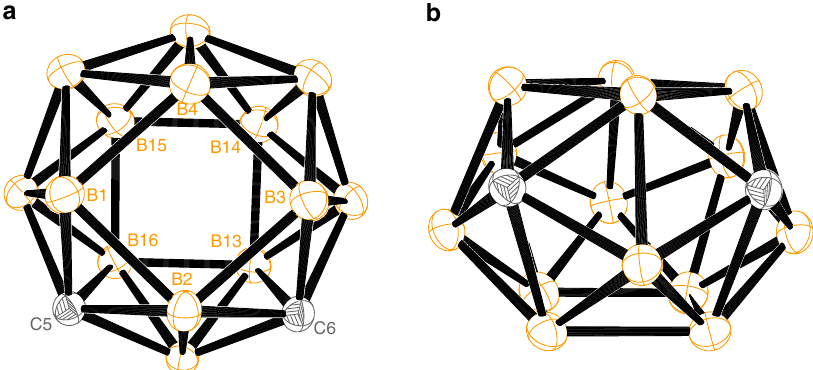
Fig. 2 Molecular structure of 16-vertex closo -carborane 5b in different view angles. a View down from the B(1)B(2)B(3)B(4) face. b View down from the C(5) and C(6) atoms. Both silyl moieties and hydrogen atoms are omitted for clarity. Orange, B; grey,